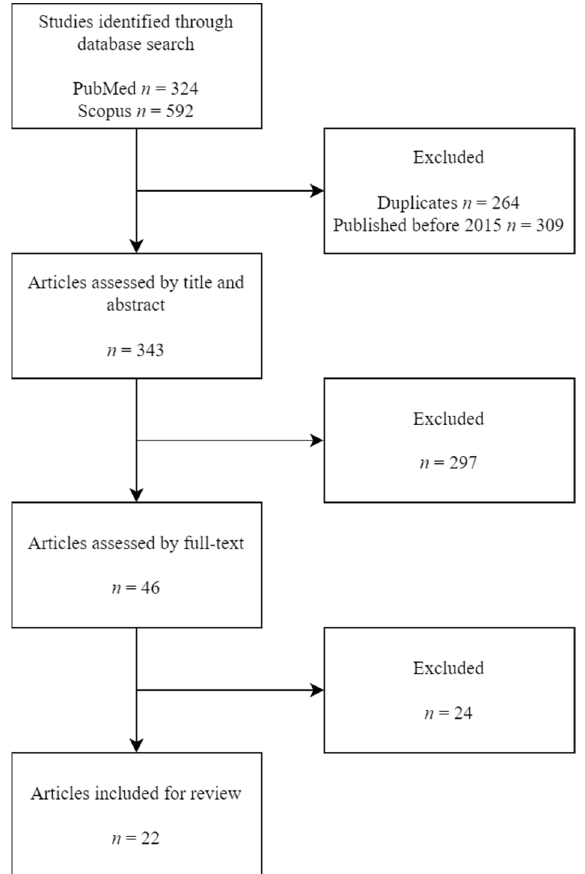
Figure 1. PRISMA flowchart.